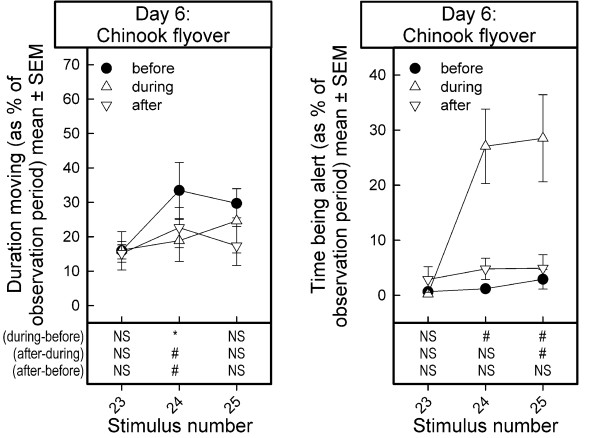
Average duration moving and time being before, during and after stimulus presentation (flyover of a Chinook helicopter) in dairy goats. Data are depicted as mean ± SEM. Note that the data of only 3 goats were available for analyzing the effects of the helicopter overflights on alertness of the goats. Results of one-sample t-statistics on the difference scores between values (during minus before), (after minus during), and (after minus before) stimulus presentation are summarized in the lower part of the figures. The list of stimuli presented is shown in Table 1. NS: no effect, p > 0.10; #: marginal effect, 0.10 > p > 0.05; *: significant effect, p < 0.05